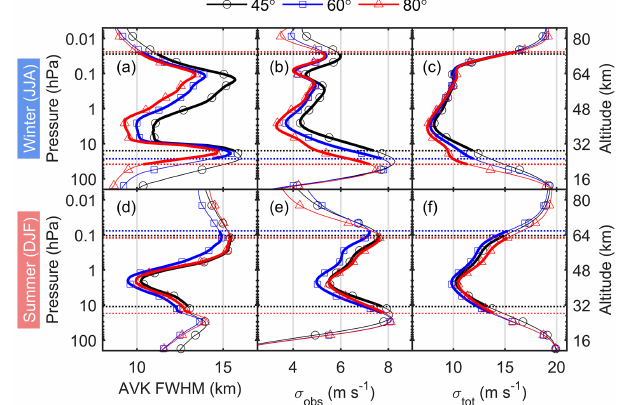
Figure 8. As Fig. 7, but for different frequency resolutions and a 60 ◦ zenith viewing